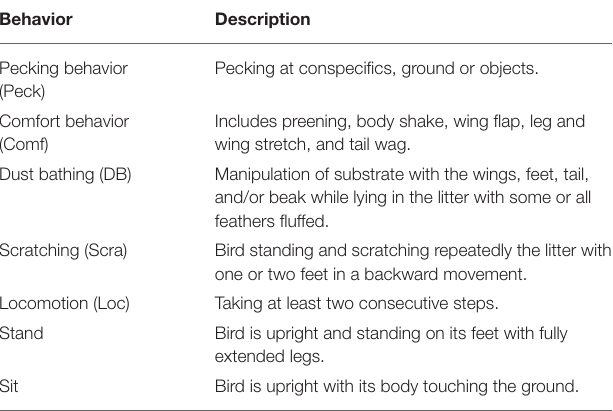
TABLE 2 | Ethogram of general behavior scans [(31) and (35), modified]. Behavior